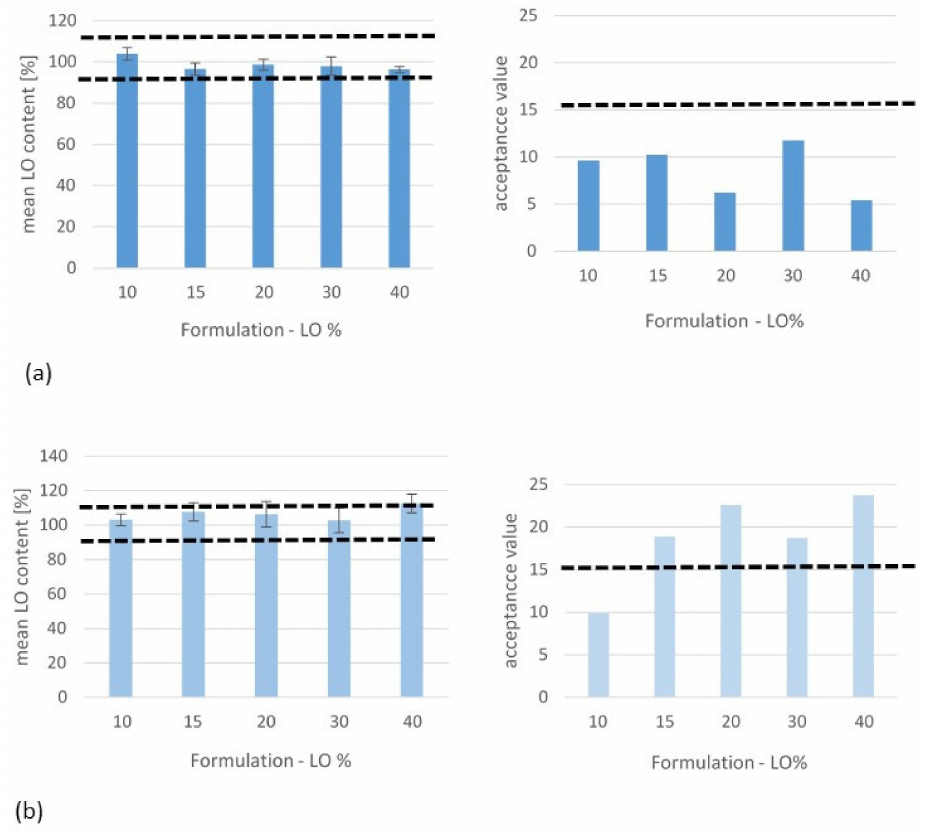
Figure 8. Uniformity of the LO content in ODFs: % of the theoretical dose in a single ODF ( n = 10, mean ± SD) and acceptance values (AV). ODFs were prepared with HPMC ( a ) or AP / PVP ( b ), with di ff erent LO loadings (10%–40% w / w ) and a casting height of 800 µ